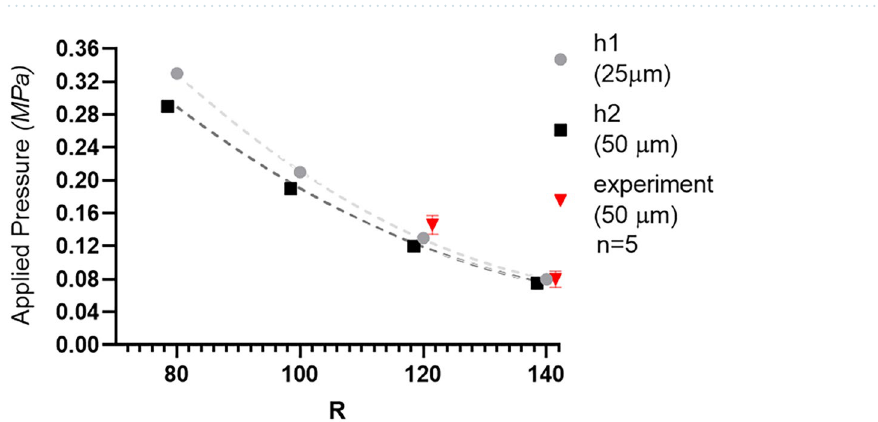
Figure 1. Multiphysics simulation of the unit valve’s (R = 140 µ, h = 50) actuation. ( a ) 2D plot of the middle cut plane indicating membrane deflection, resulting surface pressure and first principal stress, ( b ) line graph of the displacement field at various applied pressure (MPa) across the arc length, ( c ) illustration depicting an open state and ( d ) close state. Figures were generated using COMSOL Multiphysics 5.5.